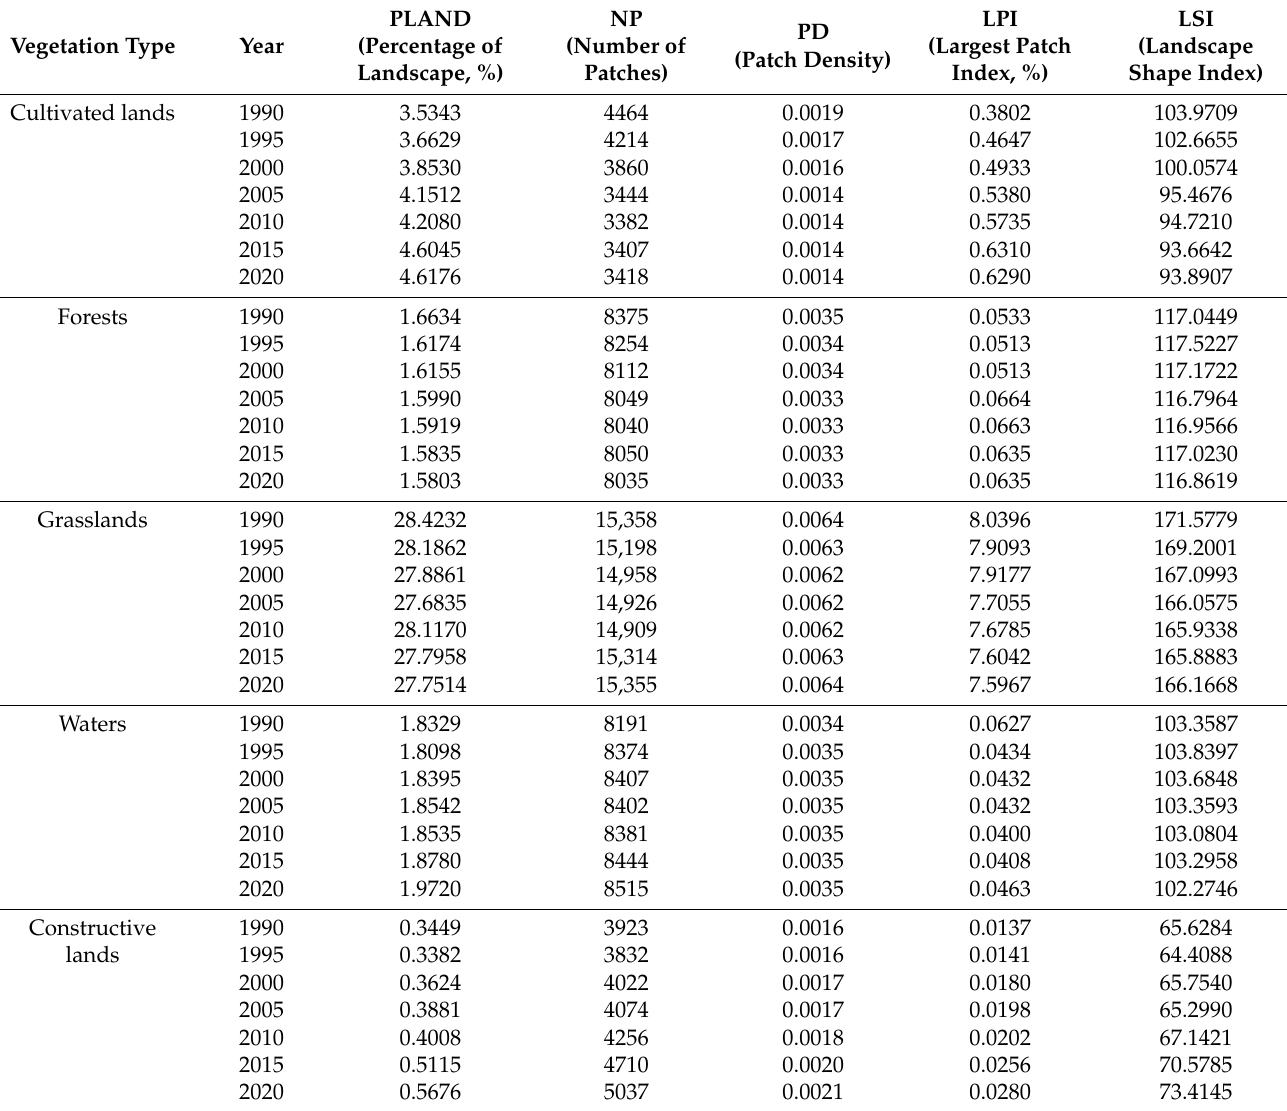
Table 2. Variation of patch type landscape pattern index in arid desert region of Northwest